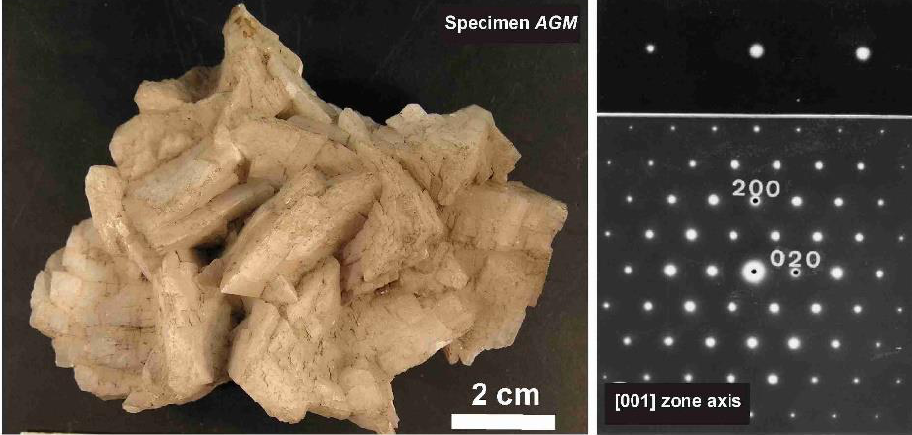
Figure 8. L eft, specimen AGM, “valencianite” from Mina Valenciana, Guanajuato, México, in Museo Nacional de Ciencias Naturales (MNCN-CSIC). Right, electron-diffraction pattern along the [001] zone axis, showing the round shape of the diffraction spots. Diffuse scattering, typical of both orthoclase and (intermediate or strained) microcline, is absent, despite of chemical disorder. The electron-diffraction pattern was obtained with a JEOL 4000EX instrument at 400 kV.